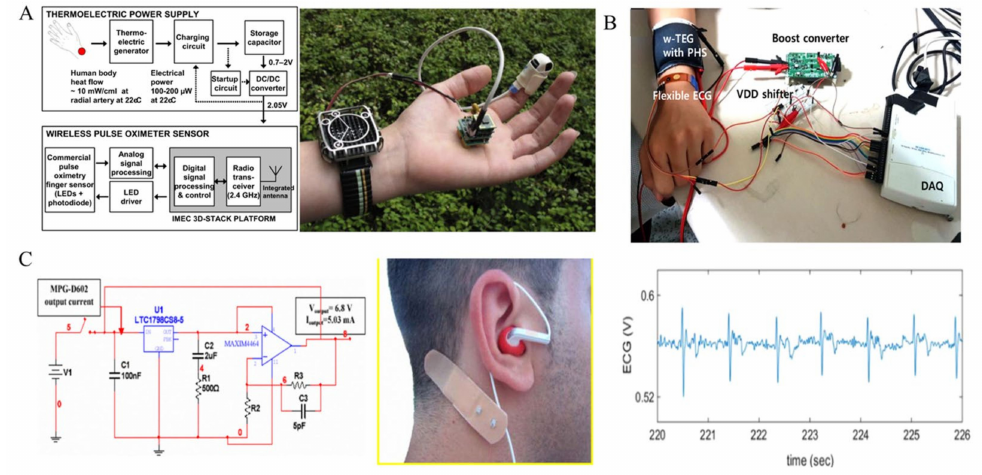
Figure 12. ( A ) Watch-type thermoelectric and oximeter [117]. ( B ) Flexible thermoelectric ECG detector [71]. ( C ) Thermal and power hearing aid